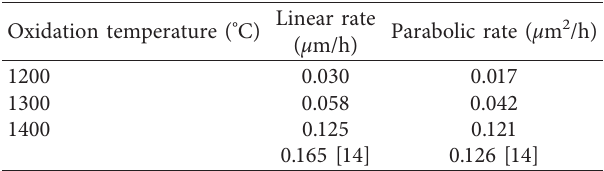
Table 1: Summary of the linear and parabolic oxidation rates of the SiC layers in TRISO particles.